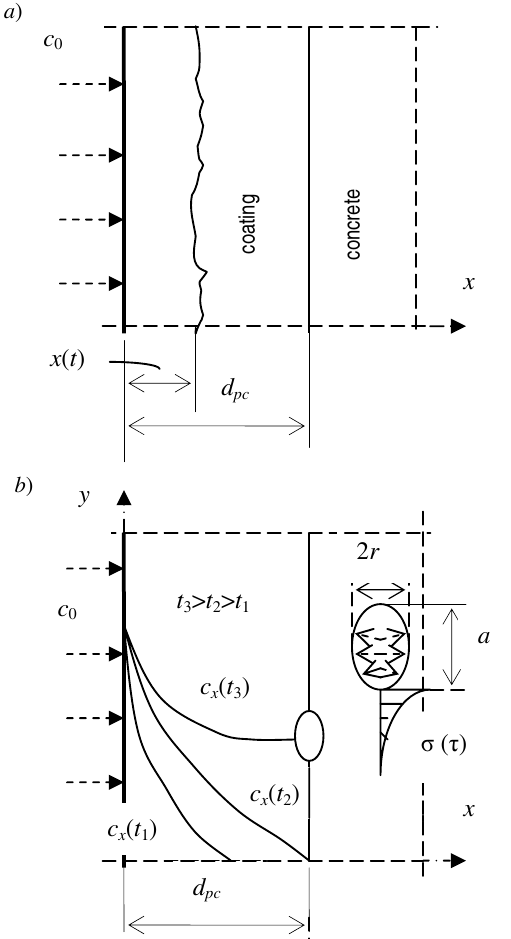
Fig 1 . Surface degradation of coating (a) and concentra- tion profiles for diffusion taken at different time